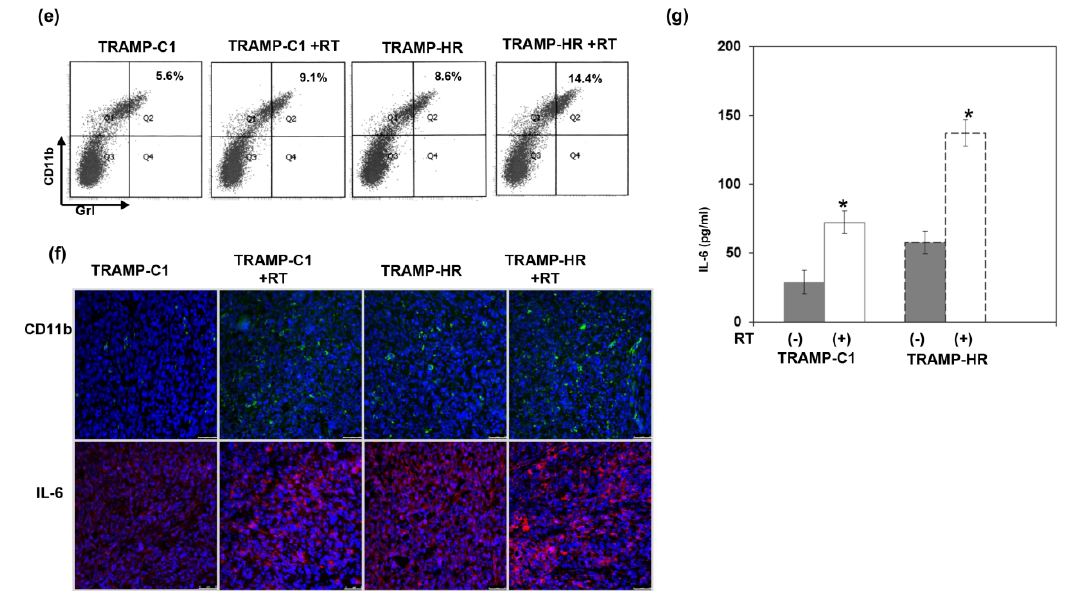
Figure 3. Radiation response of prostate cancer in an immunocompetent host. The radiosensitivity of prostate cancer (TRAMP-C1 and the corresponding CRPC cells), as demonstrated by ( a ) tumor growth delay of ectopic tumors after 15 Gy irradiation, and by ( b ) the orthotopic tumor model in immunocompetent mice. Representative images and quantitative data are shown 12 days after 15 Gy radiotherapy (RT) or sham irradiation. The y axis represents the relative ratio, normalized to the tumor size of TRAMP-C1 tumors in sham-irradiated mice (* p < 0.05). ( c ) Expression levels of Ki-67 and p-H2AX in tumors were evaluated by immunohistochemical staining (IHC) analysis. Scale bars: 20 µ m. The y axis represents the ratio normalized by the value of TRAMP-C1 under control conditions. The recruitment of myeloid-derived suppressor cells (MDSCs) was evaluated by FACS using GrI-CD11b staining in the spleen ( d ). The MDSC level was the value of the number of CD11b+Gr1+ cells divided by the total cell number. The level of MDSCs in the tumors was evaluated by FACS (e) and by immunofluorescence using CD11b staining ( f ). Scale bars: 50 µ m. The levels of interleukin (IL)-6 in the tumors were examined by immunofluorescence (IF) analysis (and in serum by ELISA with mice bearing tumors 48 h after 15 Gy RT or sham irradiation). ( g ). Columns: Means of three separate experiments; bars: SD; * p < 0.05.